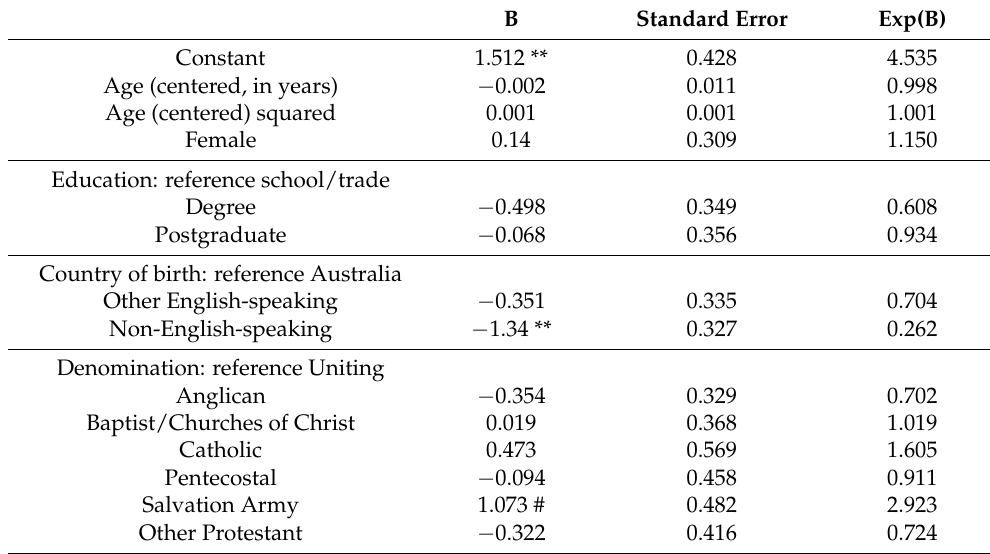
Table 8. Prediction of referred victim to service agency from demographics and